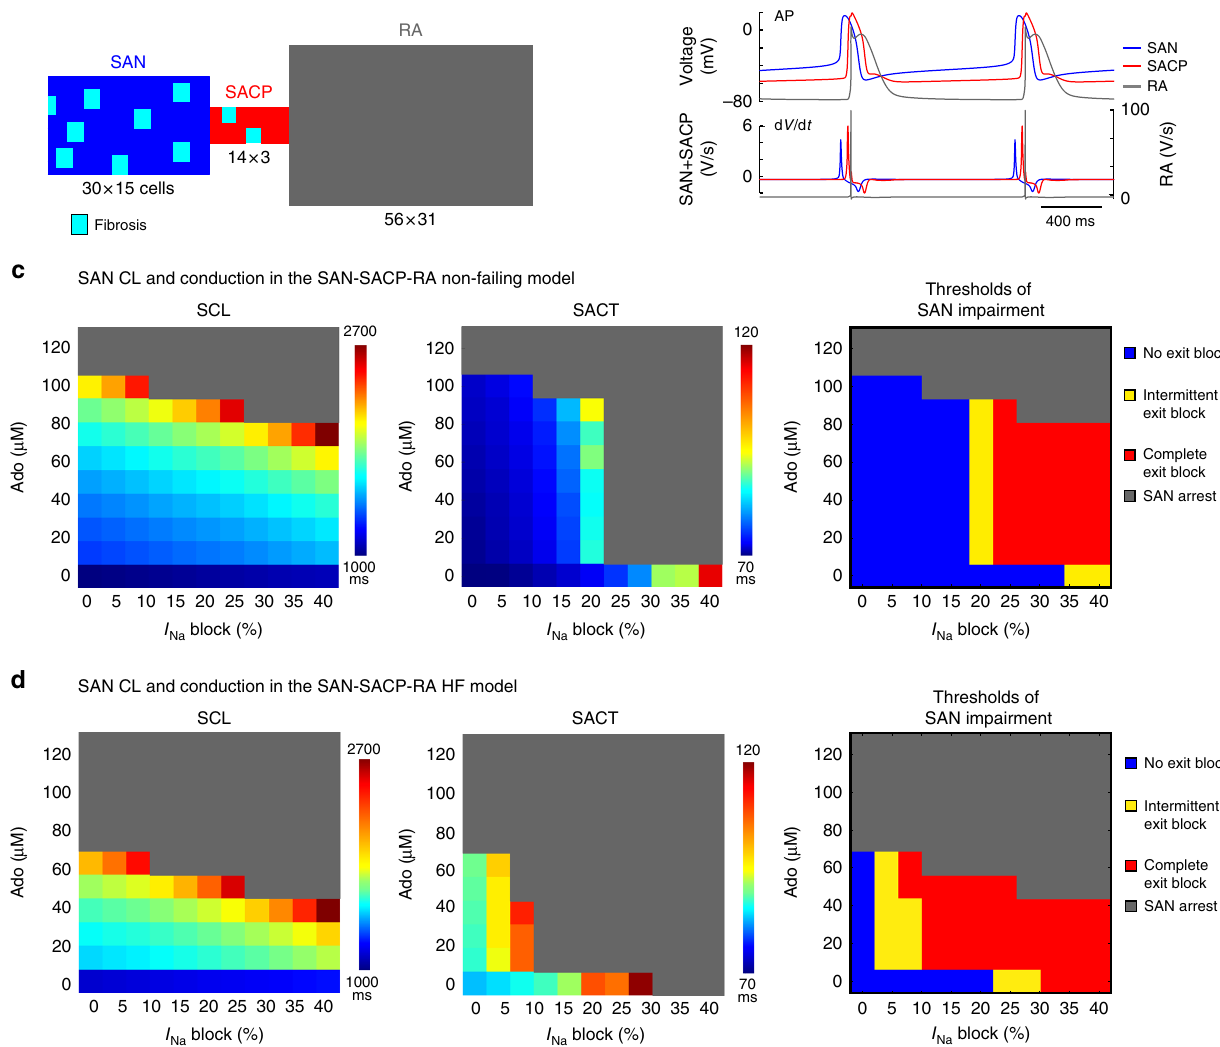
Fig. 9 Heart failure increases SAN impairment caused by Nav blockade in computer simulations. a Geometry of the 2D computer model with unexcitable fi brosis elements shown in light blue. b Action potentials (AP) and their derivatives (d V /d t ) show different electrophysiologic (EP) characteristics of SAN, SACP, and RA cells in the current model. Table results displaying combinations of adenosine dose and the percentage of sodium current ( I Na ) block in terms of cycle length, SACT, and threshold of SAN pacemaking and conduction impairment in control model ( c ) and HF model ( d ). Ado adenosine, HF heart failure, SACP sinoatrial conduction pathway, SACT sinoatrial conduction time, SAN, sinoatrial node, SCL sinus cycle